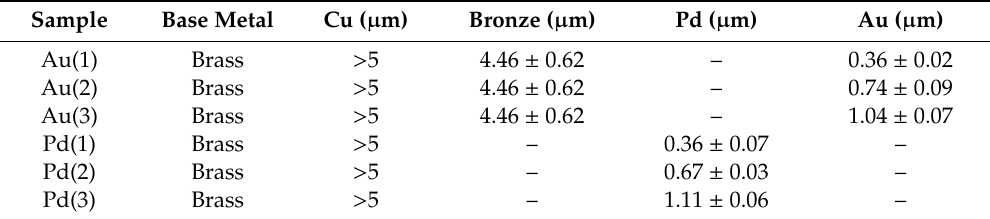
Table 1. Composition and thicknesses of the samples measured with